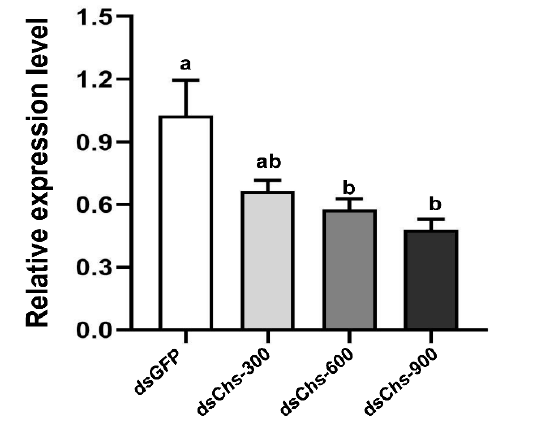
Figure 2. Transcript relative expression analysis of CHS2 in L. trifolii at different developmental stages ( A ) and adult tissues ( B ). Different lowercase letters in panels indicate significant differences between treatments. Tukey’s multiple range test was used for pairwise comparison of means ( p < 0.05).